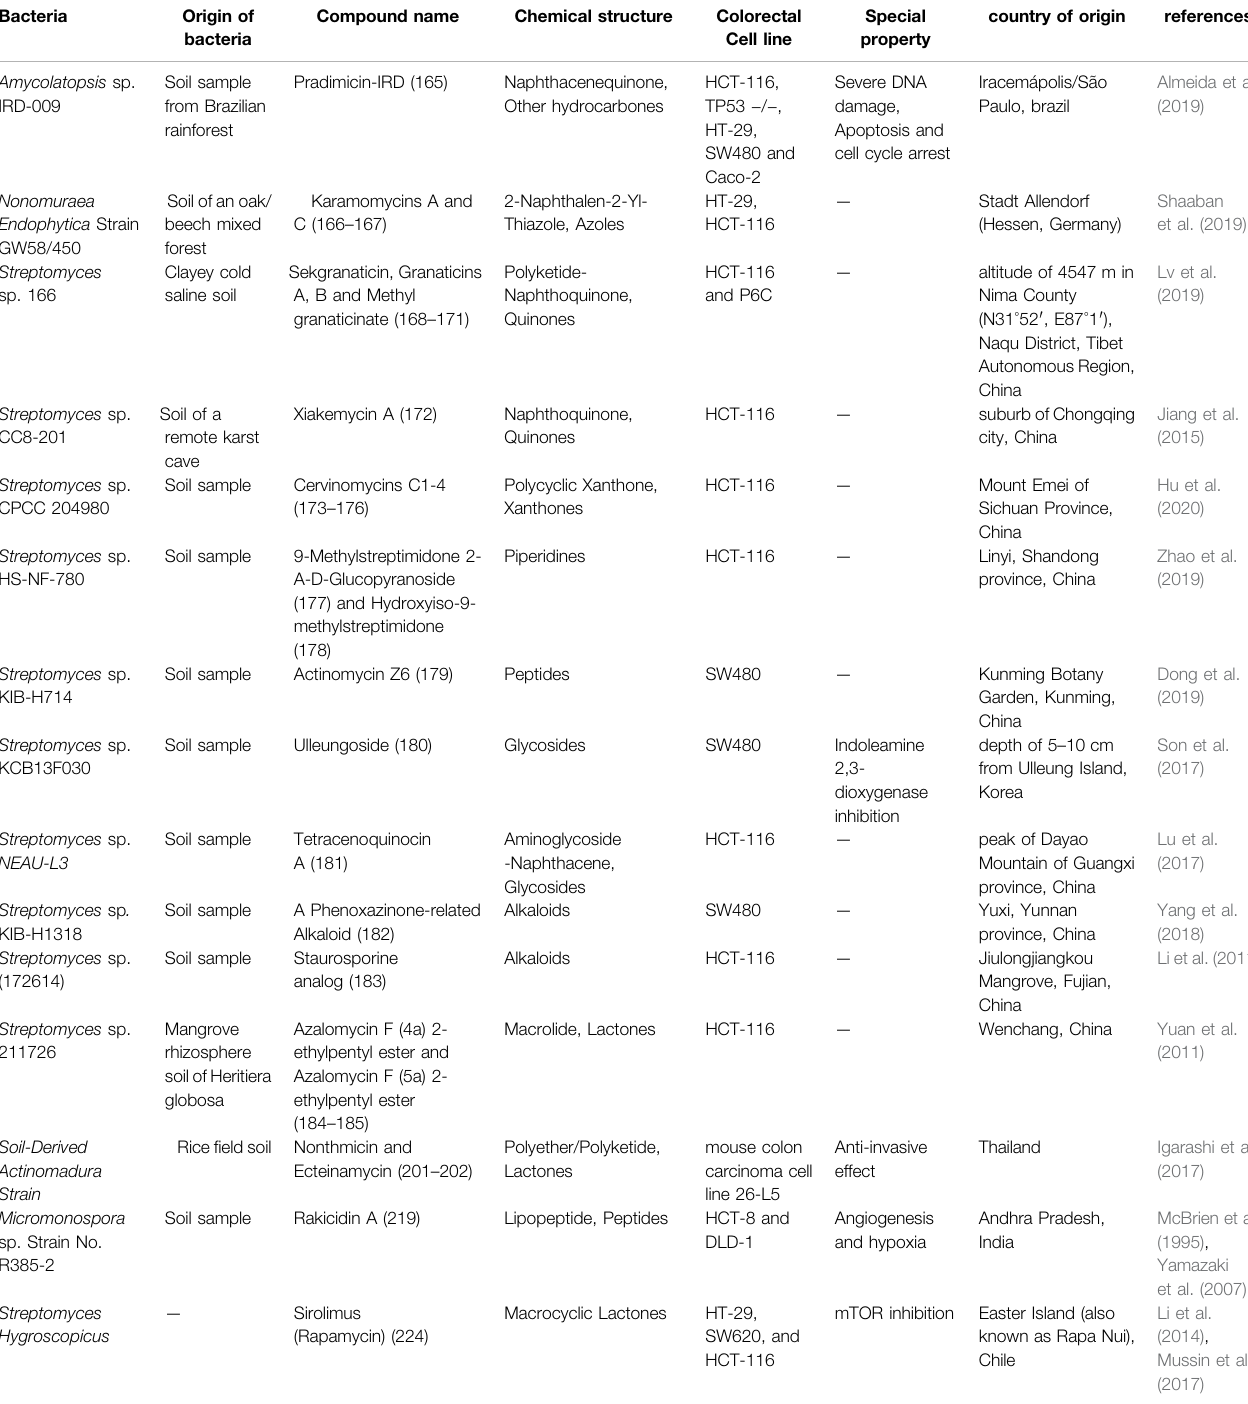
TABLE 1 | the structure of some NPs with anti-CRC properties from terrestrial actinobacteria and their mechanism of action and origin.